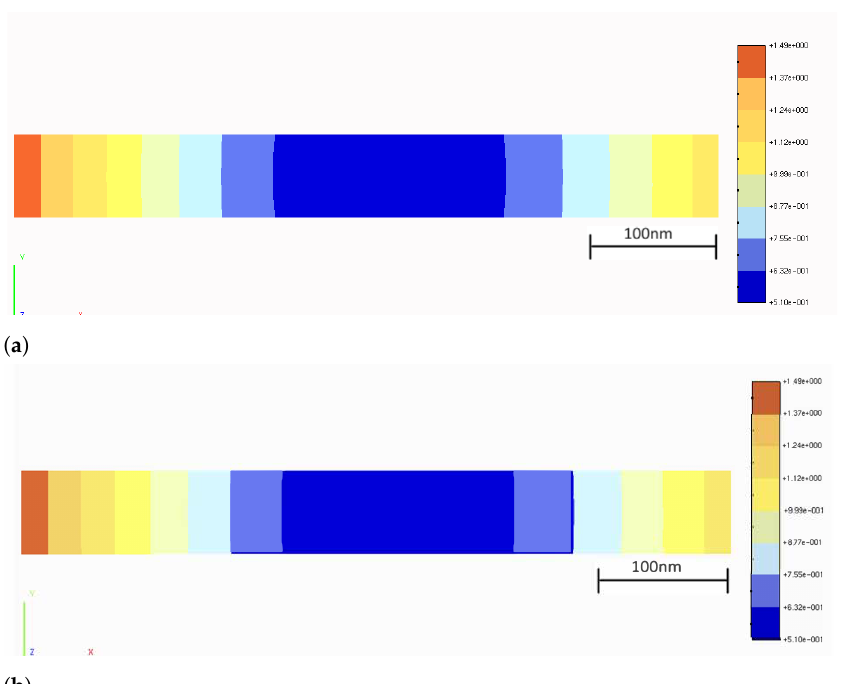
Figure 15. Vertical displacement component, u y (in mm), in the internal plane ( a ) BE analysis I: image displacement-measured displacement exclusively applied at the supports ( b ) BE analysis II: image displacement-measured data applied at the hatched area and supports